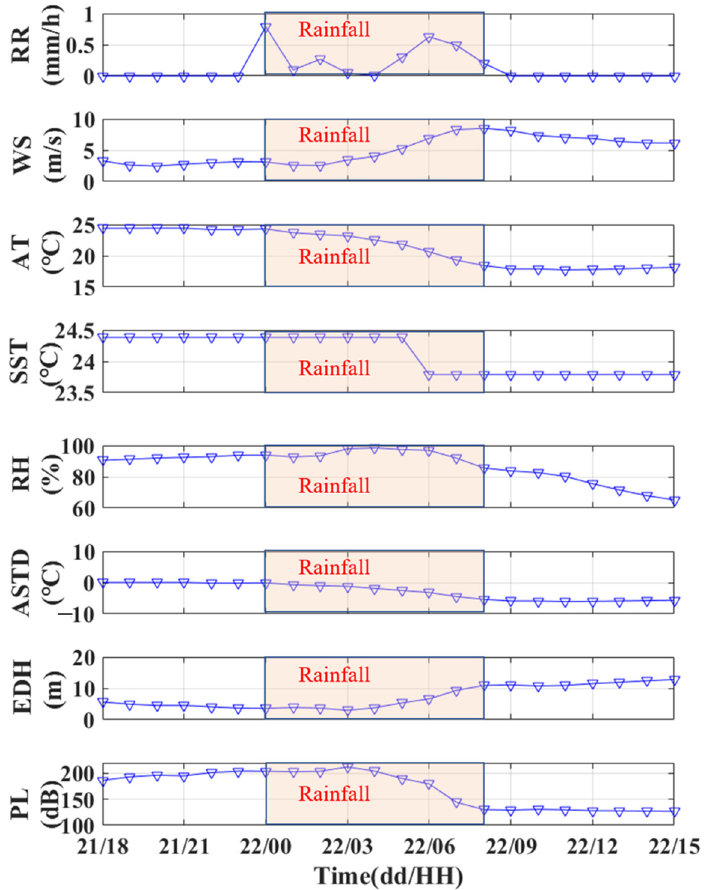
Figure 10. The factors during the study period at position C, including RR, WS, AT, SST, RH, ASTD, EDH and PL. The light pink box indicates the rainfall period.